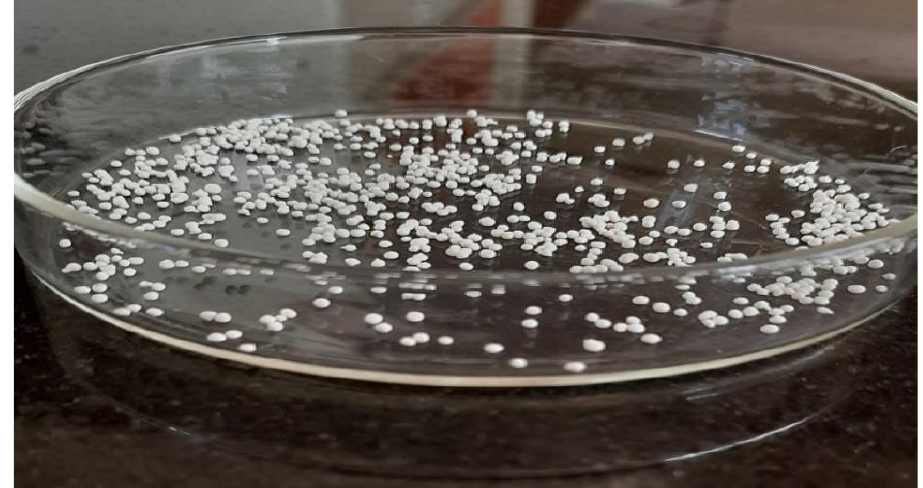
Figure 1. Image of the optimized TEL-loaded oil-entrapped floating alginate beads. 3.1.1. Effect of Formulation Factors (X1, X2, and X3) on Entrapment Efficiency Percentage (Y1)